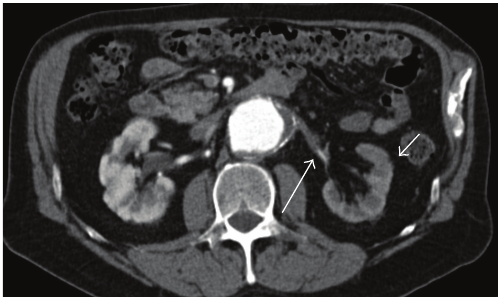
Figure 3: Preoperative CTA showing left kidney with preexistent occluded renal artery and contrast-enhancement in the cortical area (cortical rim sign, small arrow) with distal renal artery perfusion suggesting collateral (perirenal) flow (large